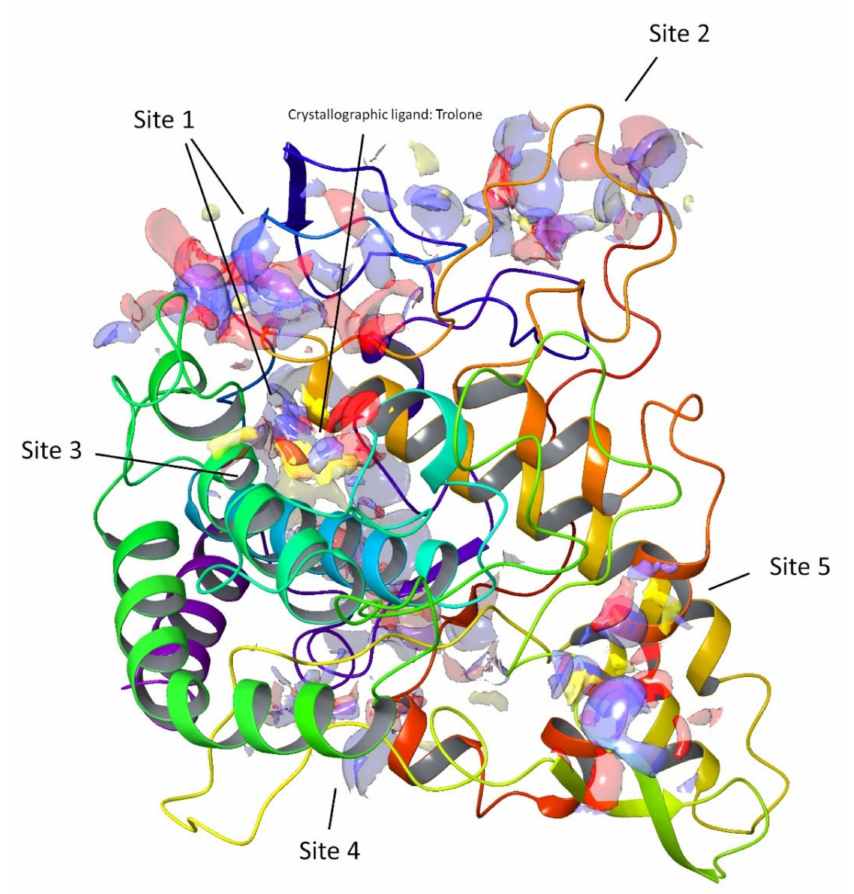
Figure 5. Top-ranked potential receptor-binding sites with hydrophobic (yellow), hydrogen-bond donor (blue), and hydrogen-bond acceptor (red) maps